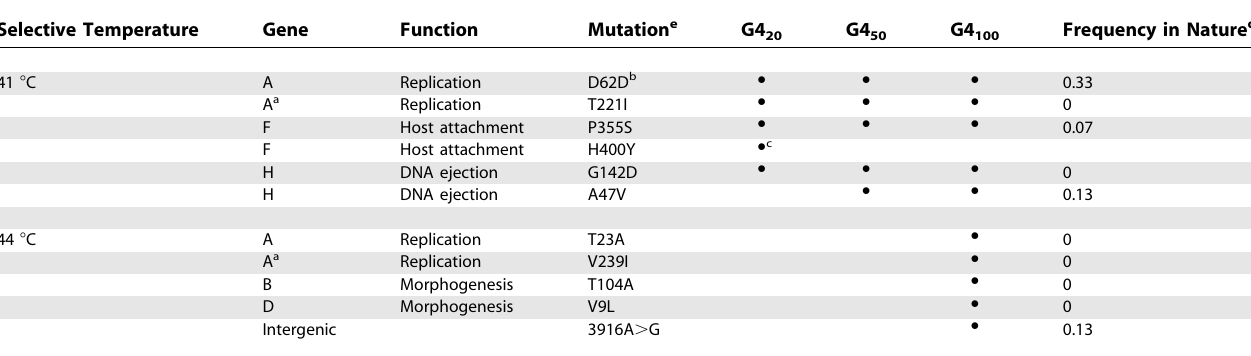
Table 2. Genetic Basis of Adaptation to High Temperature Selective Temperature Gene